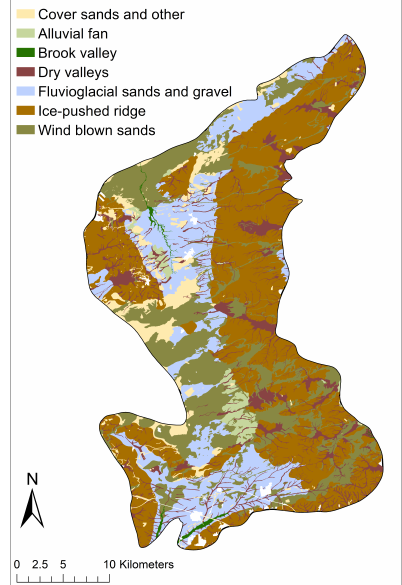
Figure 2. Main geomorphological features of the Veluwe based on Maas et al.